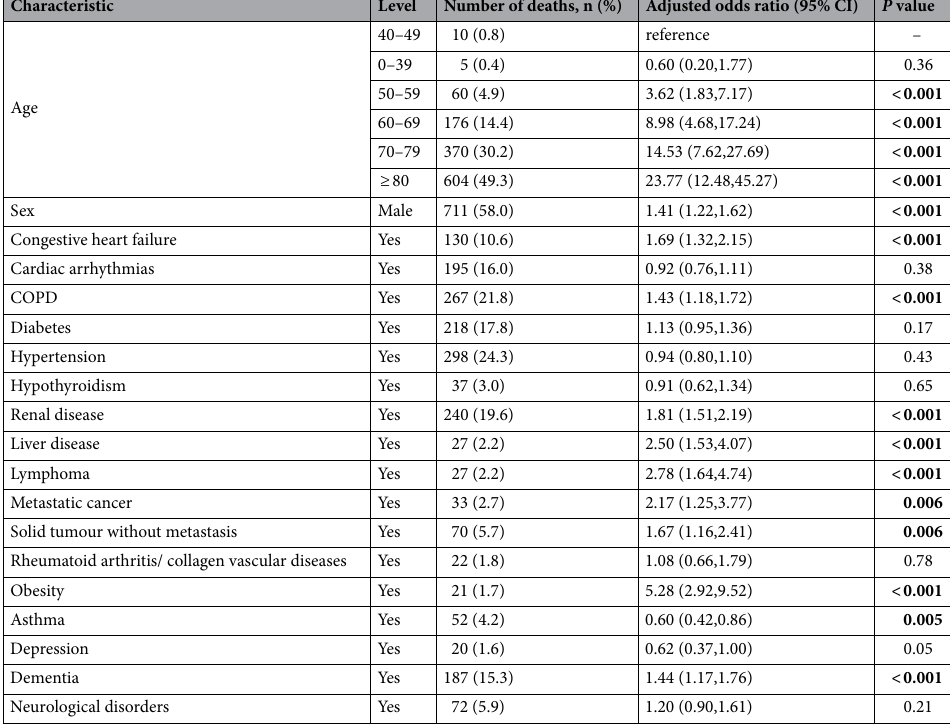
Table 2. Multivariable logistic regression analysis for factors associated with COVID-19-related death. Statistically significant P < 0.05 values are in bold. Observations, n = 6036, including 1225 COVID-19 deaths. CI Confidence Interval; COPD Chronic obstructive pulmonary disease.